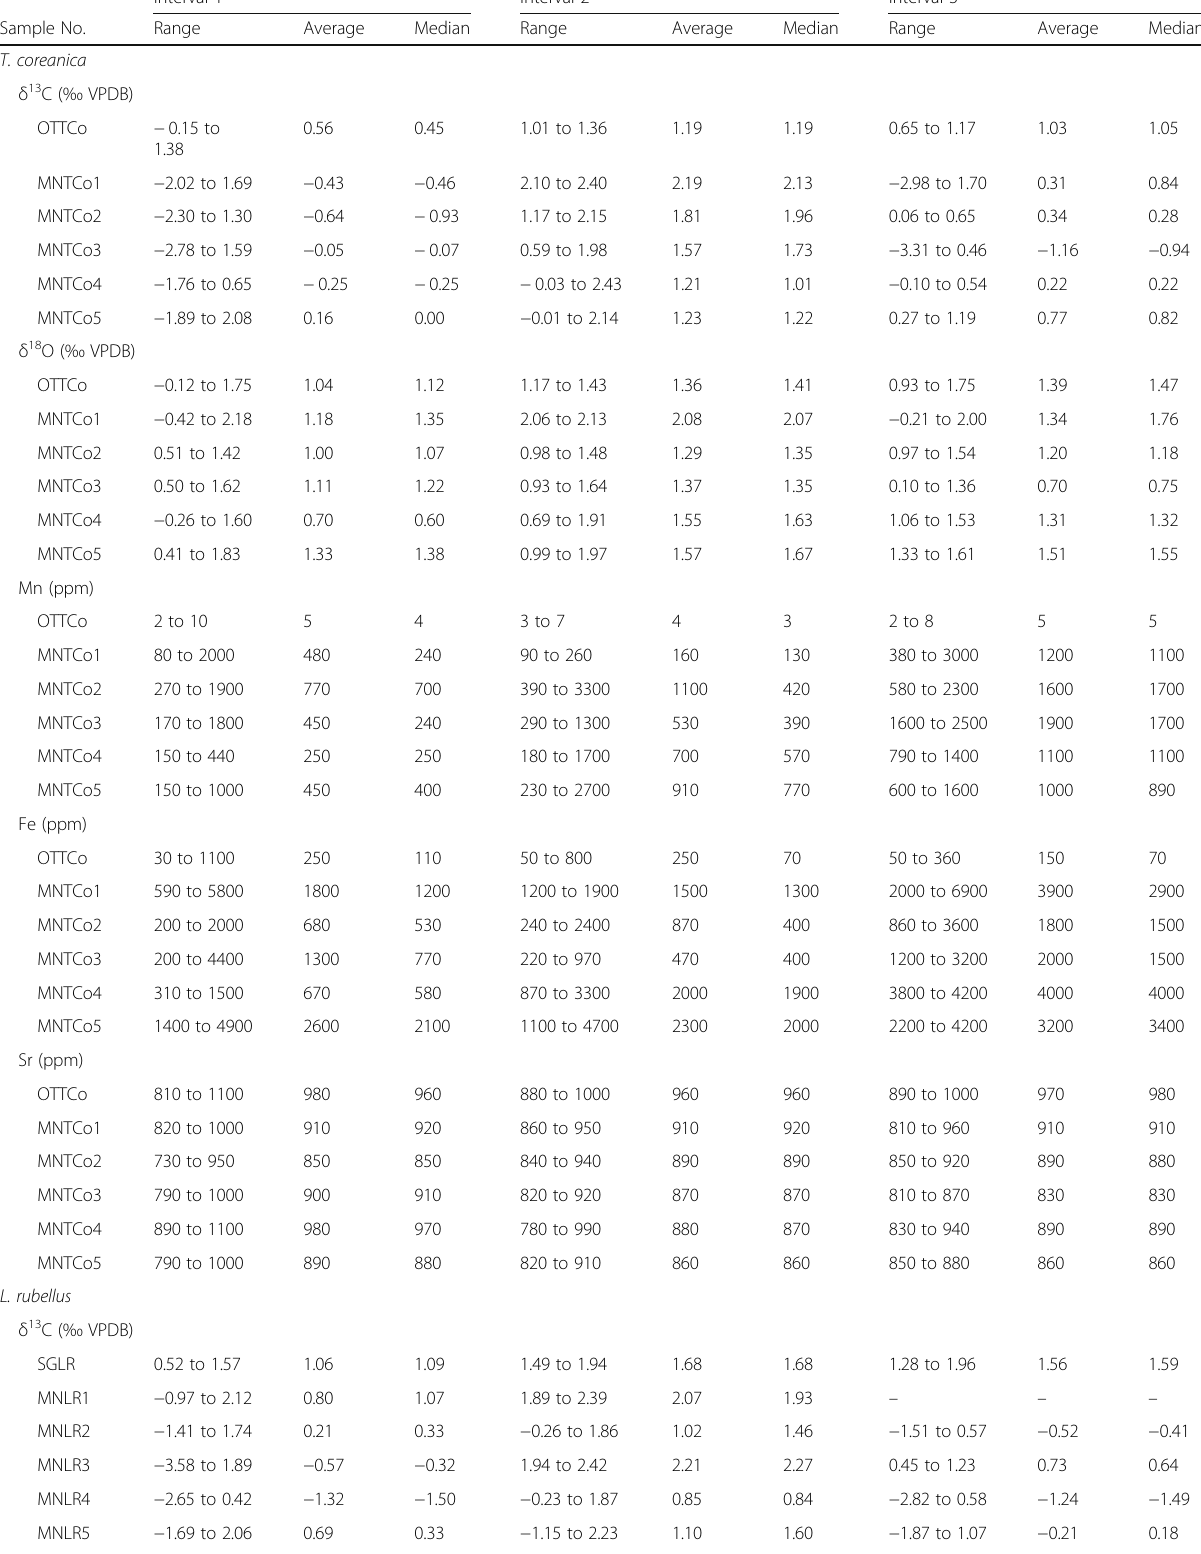
Table 1 Modern and fossil Terebratalia coreanica and Laqueus rubellus δ 13 C and δ 18 O values and minor-element concentrations Interval 1 Interval 2 Interval 3 Sample No. Range Average Median Range Average Median Range Average